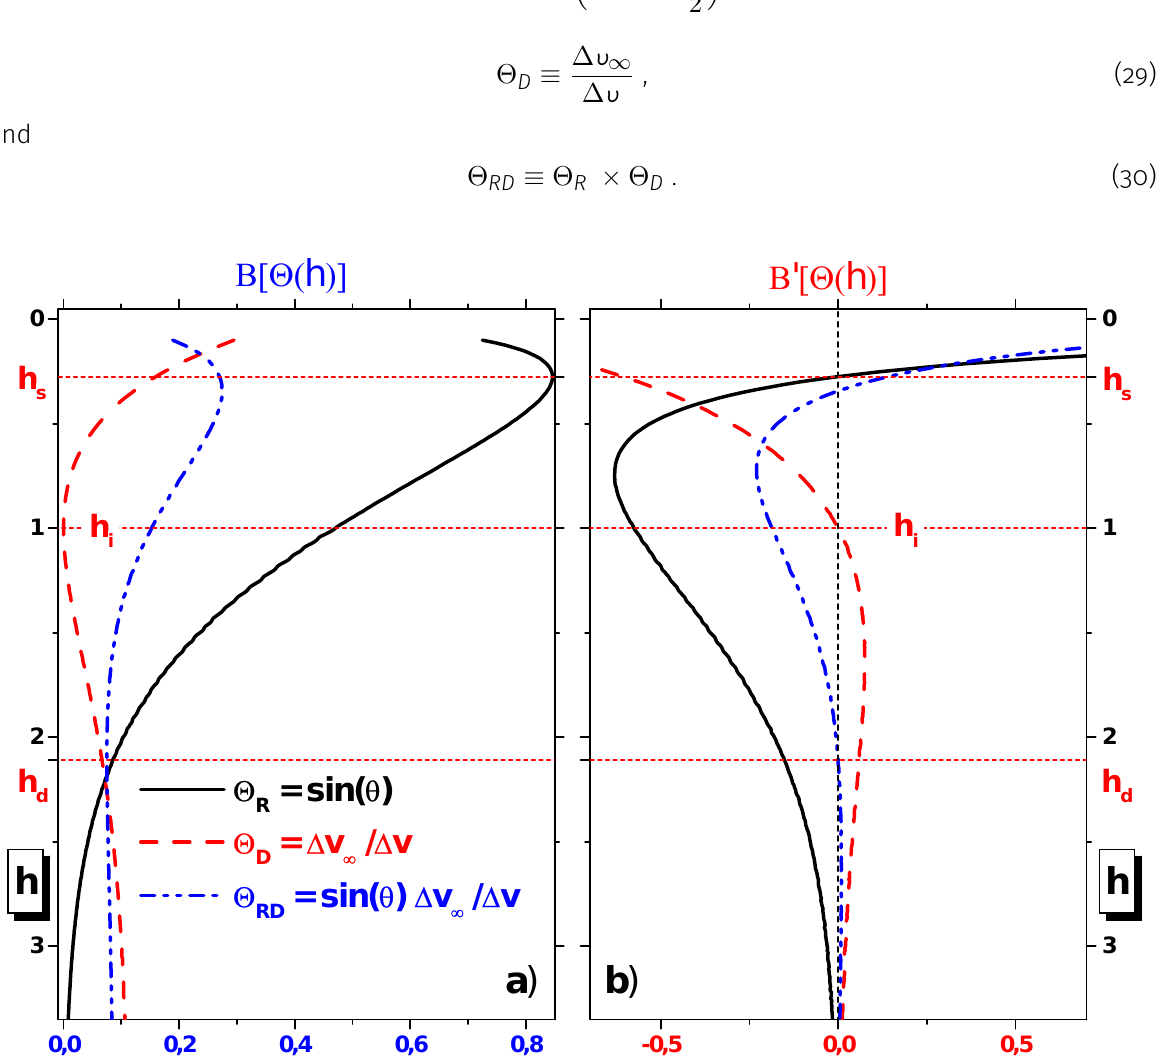
Figure 3. sketches the behavior of the CCCDF, in the cases associated with refraction and dispersion of waves as well as for the situation where the refraction and dispersion effects can occur simultaneously. Note that the panels a) and b) show respectively how in these cases the Bersntein’s polynomial BBB and its derivative B (cid:48) B (cid:48) B (cid:48) behave as hhh